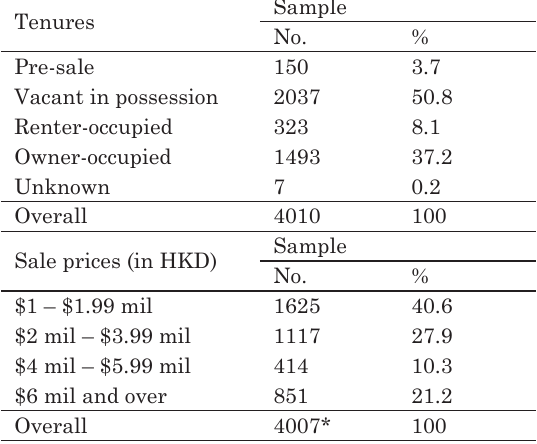
Table 3. summary